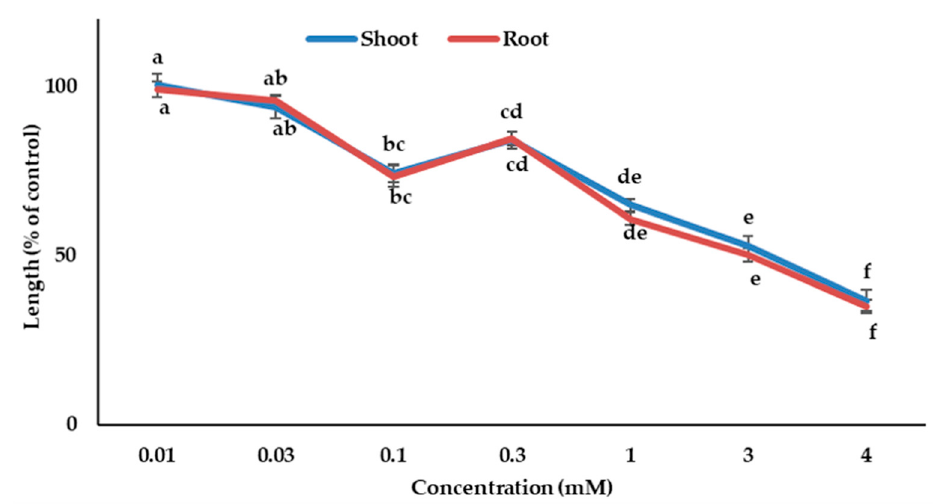
Figure 5. The phytotoxic effects of dehydrovomifoliol on the growth of the cress seedling. The mean ± standard error from the two independent experiments with three replications (10 seedlings per replication) for each experiment is presented. Different letters denote the significant differences according to Tukey’s HSD test at a 0.05 probability level.